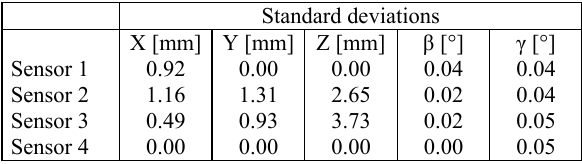
Table 2. Standard deviations for relative